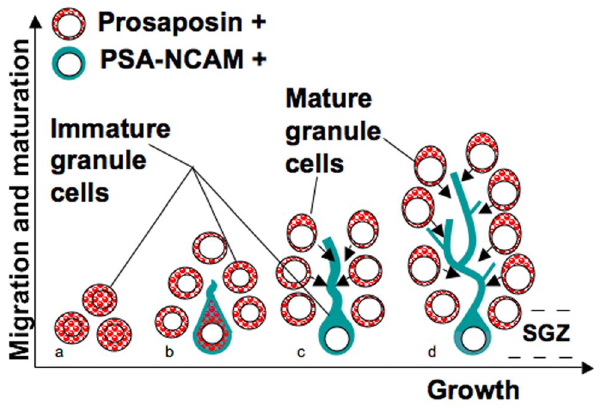
Figure 8. A scheme showing PS expression. A scheme showing the stages of neurogenesis and the expression pattern of PS and PSA- NCAM in the dentate gyrus at P3 ( a ), P7 ( b ), P14 ( c ), and P28 ( d ). Arrows indicate putative paracrine secretion of PS.